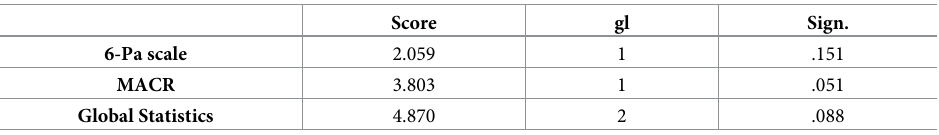
Table 6. Covariates not included in the prediction